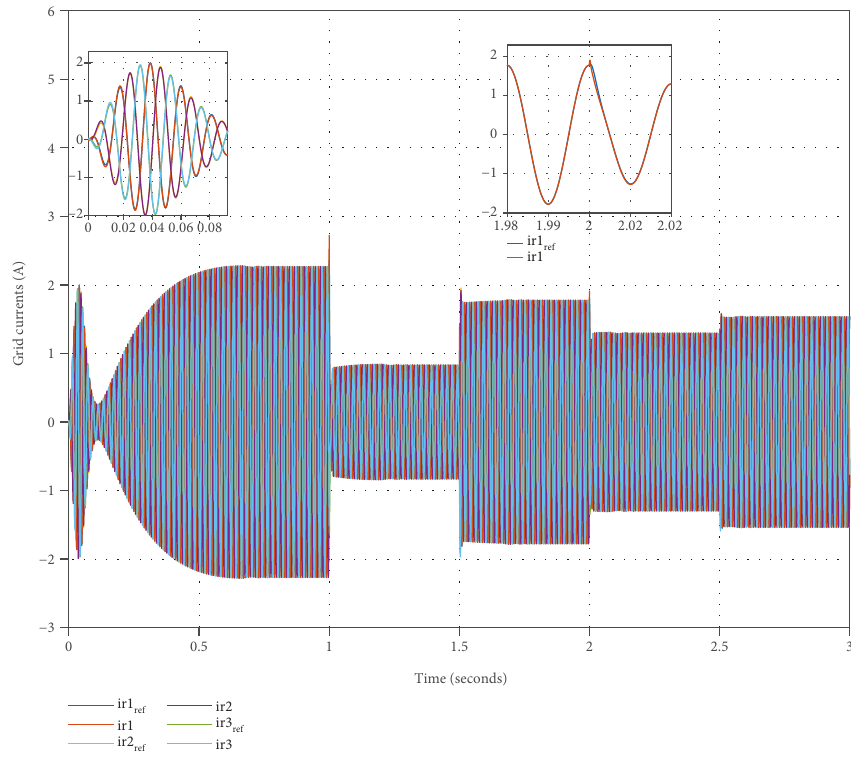
Figure 11: Grid currents (GA-FOPID control).